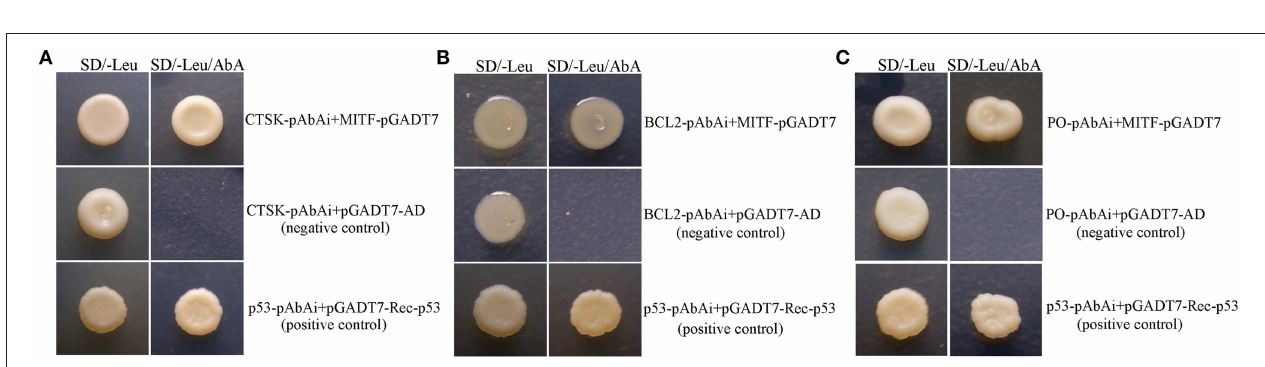
FIGURE 4 | (A–C) Yeast one-hybrid analysis of MpMITF binding to the MpPO/MpCTSK/MpBCL-2 promoters. The MpPO/MpCTSK/MpBCL-2-pAbAi plasmid together with the pGADT7-MITF effector plasmid were cotransformed into Y1HGold cells to validate the interaction. The positive control was generated by cotransforming the pGADT7-Rec-p53 and p53-pAbAi plasmids into Y1HGold cells. The Y1HGold strain cotransformed with the MpPO/MpCTSK/MpBCL-2-pAbAi and pGADT7-AD plasmids was used as a negative control. The normal growth of all Y1HGold yeast strains on SD plates without Leu (SD/-Leu) indicated that the yeast growth status was healthy (left). Only the strains containing the effector plasmid pGADT7-MITF and the positive control showed growth on SD/-Leu containing 300ng/ml aureobasidin A (SD/-Leu/AbA, right), suggesting a specific interaction between the MpPO/MpCTSK/MpBCL-2 promoters and